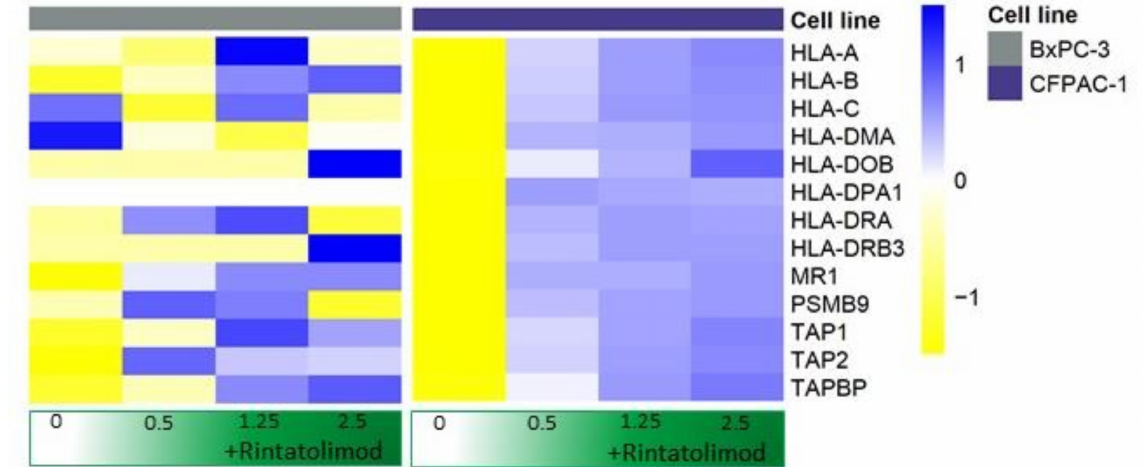
Figure 3. Rintatolimod induced the expression of MHC class I and II histocompatibility in HPDA cells. Heat maps of HLA-genes that were differentially regulated as an effect of Rintatolimod. The expressions were gene-wise scaled and are displayed as colors ranging from blue (high expression) to yellow (low expression) as shown in the key. Cells were treated with various concentrations of Rintatolimod displayed as the intensity of green color from dark green (high dose) to white (PBS